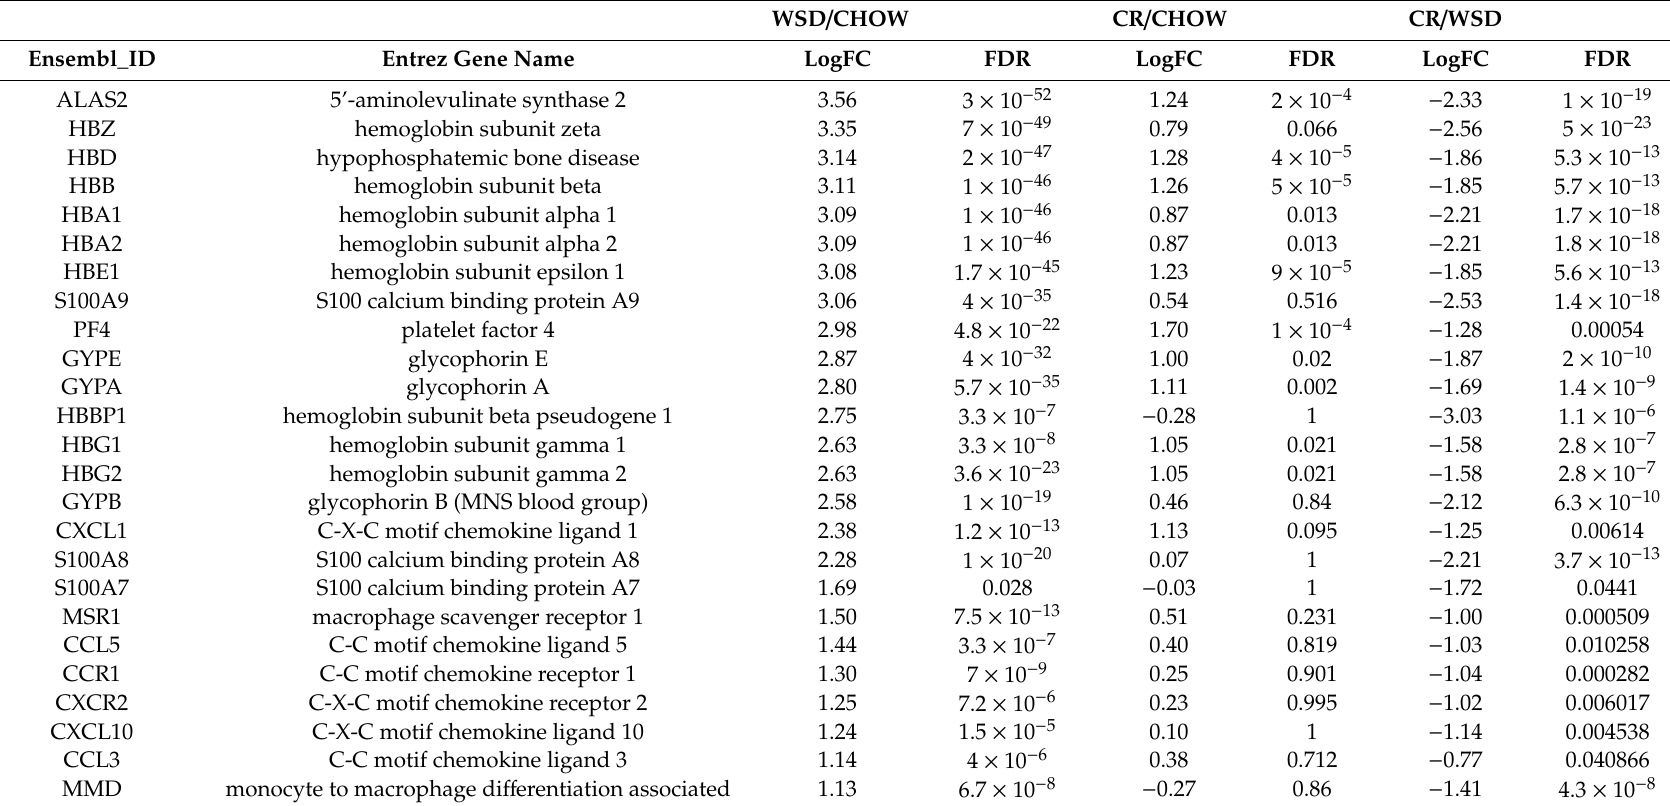
Table 1. Top western-style diet (WSD)-induced genes whose expression was reversed by caloric restriction